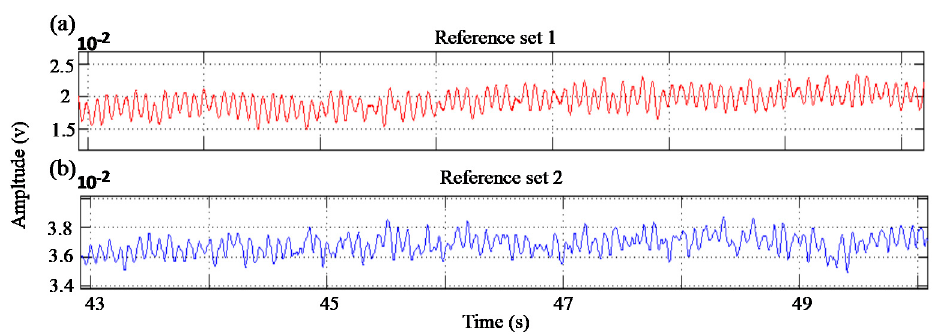
Figure 24. Comparison of retrieved EMT signal using different reference dipole arrays: ( a ) dipoles L2, L3 and L8 were used as reference signals; and ( b ) dipoles L4, L5 and L7 were used as the reference signal. The displayed result with a time frame of 43 to 50 s is extracted from the first 100 s time band data. The images are the processing result after combining the adaptive noise canceling output with 10 Hz sine wave signal.